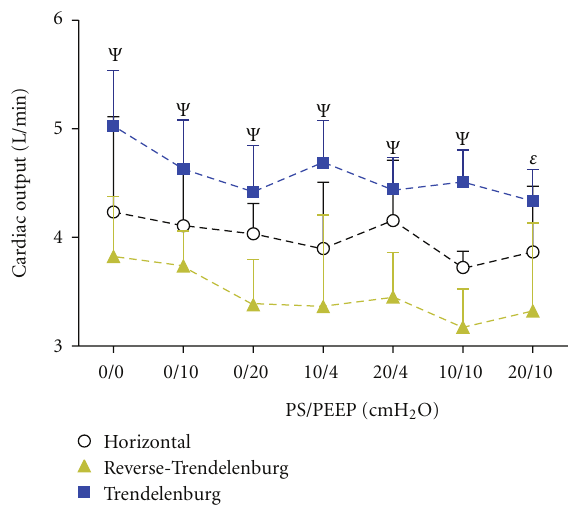
Figure 4: E ff ects of alternating positioning and varying positive pressure ventilation on cardiac output (CO). A clear association between positioning and CO was observed supporting the e ffi cacy of our model of preload variation with positioning ( P < 0 . 001). Ψ : P < 0 . 005 and ε : P < 0 . 05 for independence of positioning at individual ventilator settings. Data are presented as median and upper interquartile